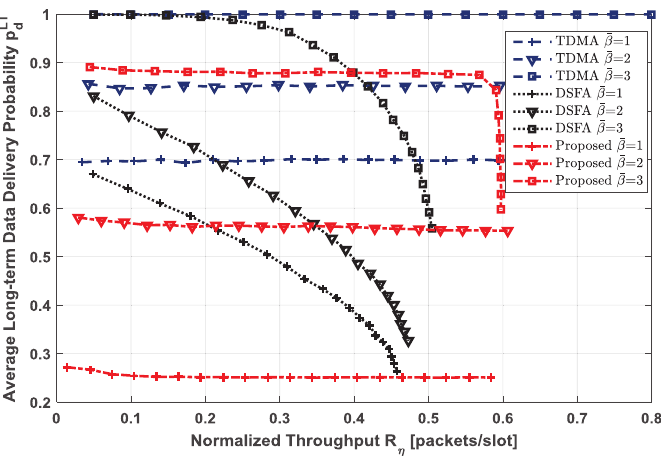
Figure 7. Trade-off between average long-term data delivery probability and network normalized throughput under different EH rates ¯ β ∈ { 1,2,3 } , e max = 10. For access schemes, number of time slots in each frame N = 200 (only for time division multiple access (TDMA) and the proposed scheme, since the frame length of dynamic frame slotted Aloha (DFSA) is dynamic), QPSK modulation, E s / N 0 = 10